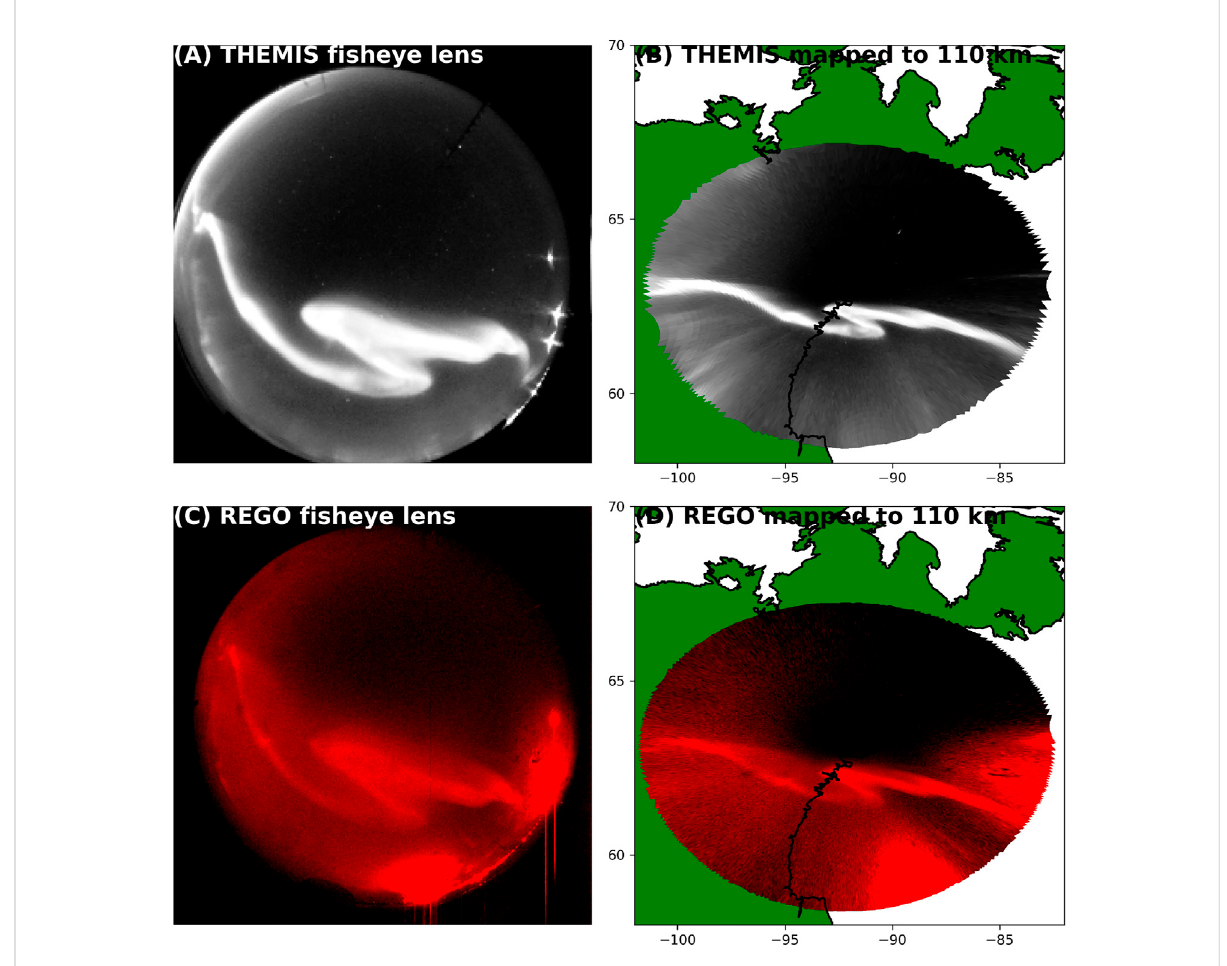
FIGURE 2 AnauroralarcobservedsimultaneouslybytheREGOandTHEMISimagersatRankinInlet,Canada.Panels (A) and (C) showthe fi sheyelensview, while panels (B) and (D) show the same images projected to the 110 km assumed aurora emission altitude. Only the pixels with elevation > 10 ° are